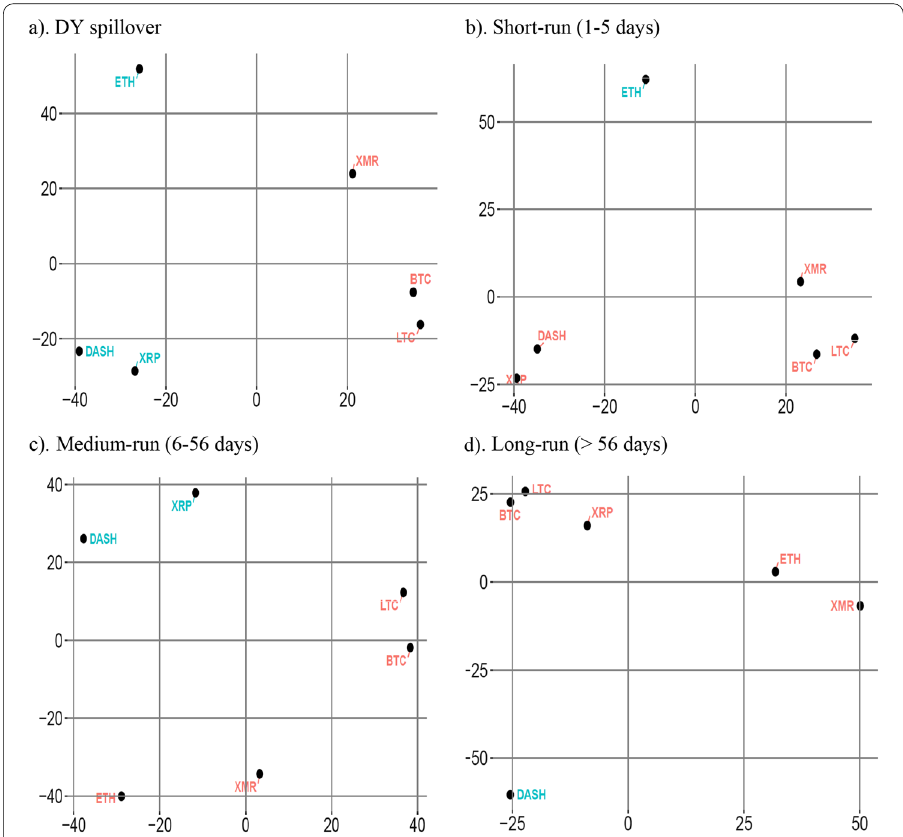
Fig. 8 Robustness check using VoV—clusters based on decomposed spillover